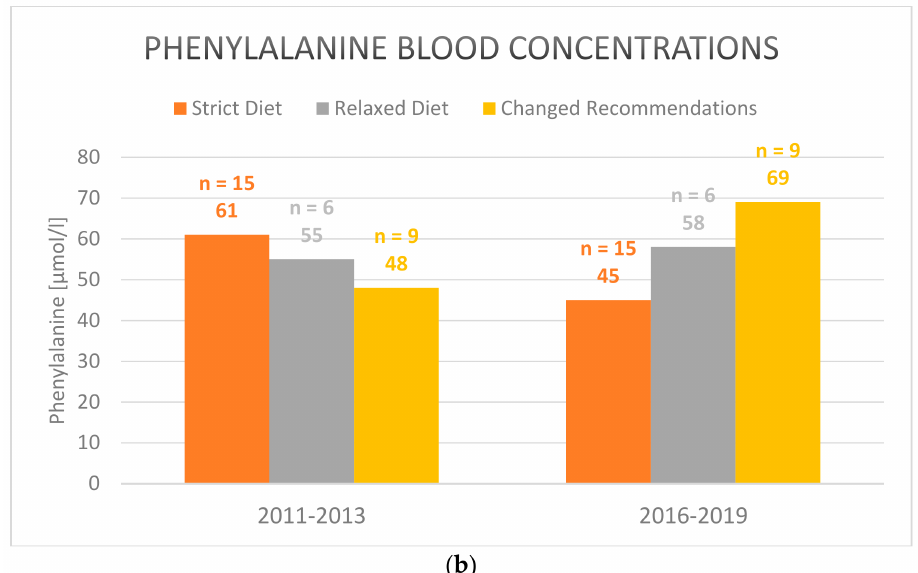
Figure 1. Mean ( a ) tyrosine and ( b ) phenylalanine blood concentrations in plasma under strict, relaxed/simplified and changed diet in the 2011–2013 and 2016–2019 periods (2016–2019 vs. 2011– 2013 for the group with changed recommendations after the workhsop: tyrosine blood concentrations: p = 0.007; phenylalanine blood concentrations: p = 0.153). Only those patients are included